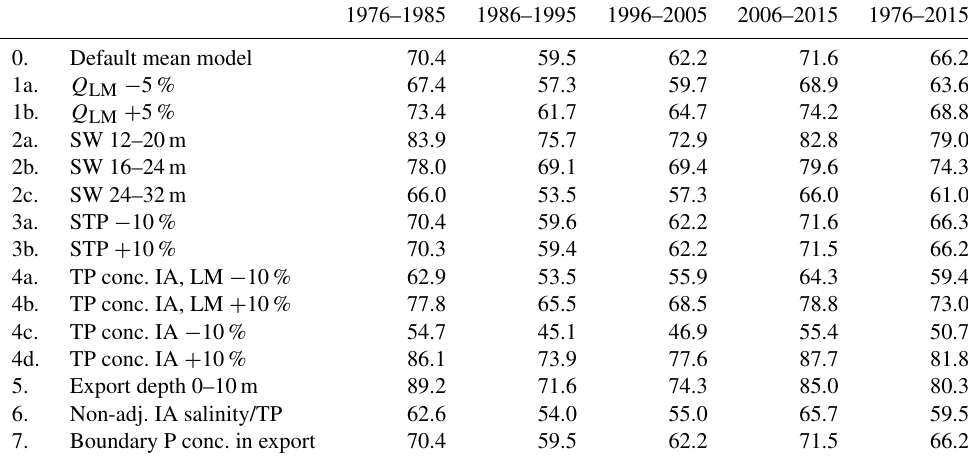
Table 4. Effects of sensitivity tests on deep-layer ( > 20m) P release (tyr − 1 ) in the inner archipelago (IA) using the mean model. Year 2011 is excluded. Sensitivity tests included (1) variations in freshwater flow with Lake Mälaren ( Q LM ), (2) recruitment depth of inflowing salt water (SW) from the middle archipelago (affecting salinity and P), (3) sewage treatment plant (STP) discharge of P, (4) water P concentrations in the IA and Lake Mälaren (LM), (5) a deeper layer for water export from the IA, (6) non-adjusted data from central IA stations (see methods), and (7) use of the boundary P concentration for export from the